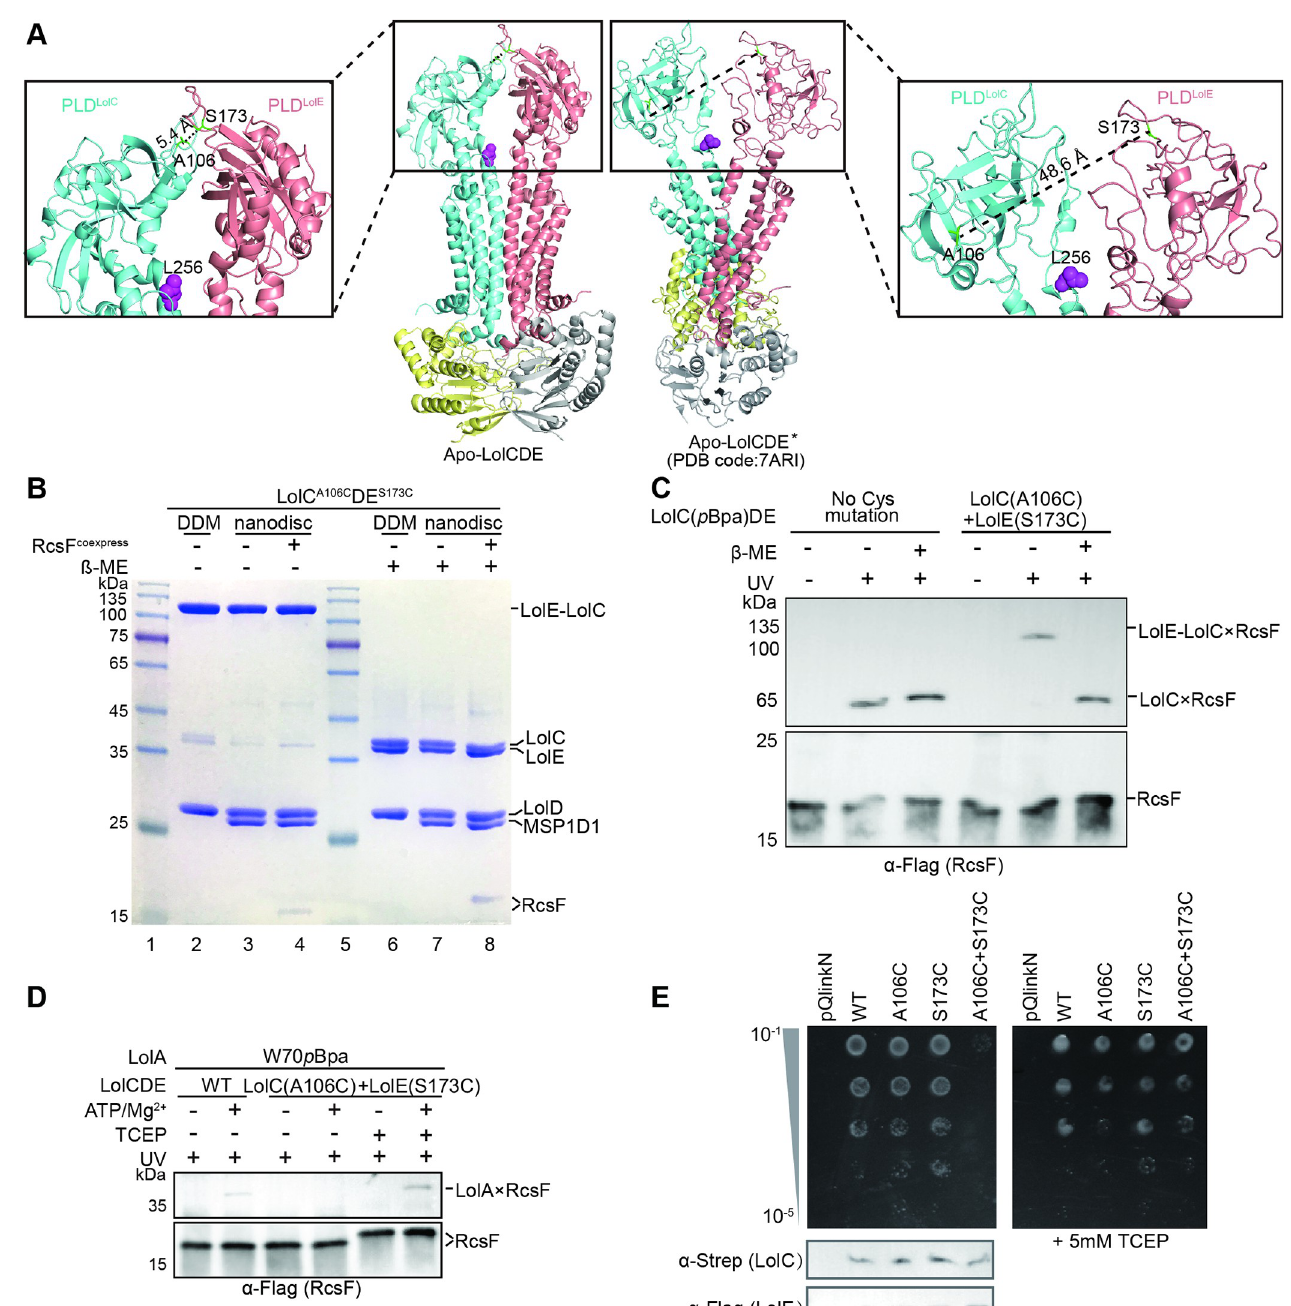
Fig 2. Verification of the apo-LolCDE structure. ( A ) Comparison of our apo-LolCDE structure (left) to the apo-LolCDE � structure (right, PDB code:7ARI). Zoom-in view showing 2 amino acids in 2 PLDs, Ala106 and Ser173, which were replaced with cysteines in (B to E). Leu256 LolC shown in purple spheres was substituted with p BPA for in vitro photo-crosslinking in (C). ( B ) Coomassie-stained SDS–PAGE gel assessing disulfide bond formation of LolC A106C DE S173C and RcsF-LolC A106C DE S173C . The samples of lanes 2 through 4 were supplemented with SDS loading dye without β -ME, and the samples of lanes 6 through 8 were supplemented with SDS loading dye with β -ME. Note that RcsF migrates slower after addition of reducing agent. ( C ) In vitro photo-crosslinking. LolC L256 p BPA DE proteins with or without 2 cysteine mutations were reconstituted with RcsF in nanodisc. The LolC × RcsF and the LolE-LolC × RcsF adducts were detected by immunoblotting. ( D ) The in vitro lipoprotein transport assays. To break intermolecular disulfide bond, the nanodisc-embedded RcsF-LolC A106C DE S173C protein was incubated with TCEP prior to the addition of LolA (W70 p BPA). ( E ) Complementation assays. The dilutions were spotted on LB plates with (right) or without (left) TCEP. Protein leaky expression levels of the LolC and LolE proteins were detected by western blotting (bottom). Data shown in (B to E) are representatives of 3 replicates.